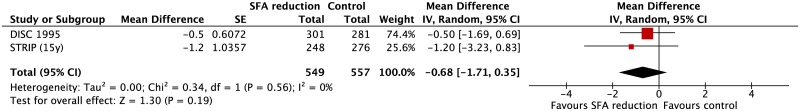
Meta-analysis of weighted mean (95% CI) differences in effects on systolic blood pressure (mm Hg) in randomised trials that compared usual diets with reduced saturated fat diets in children.